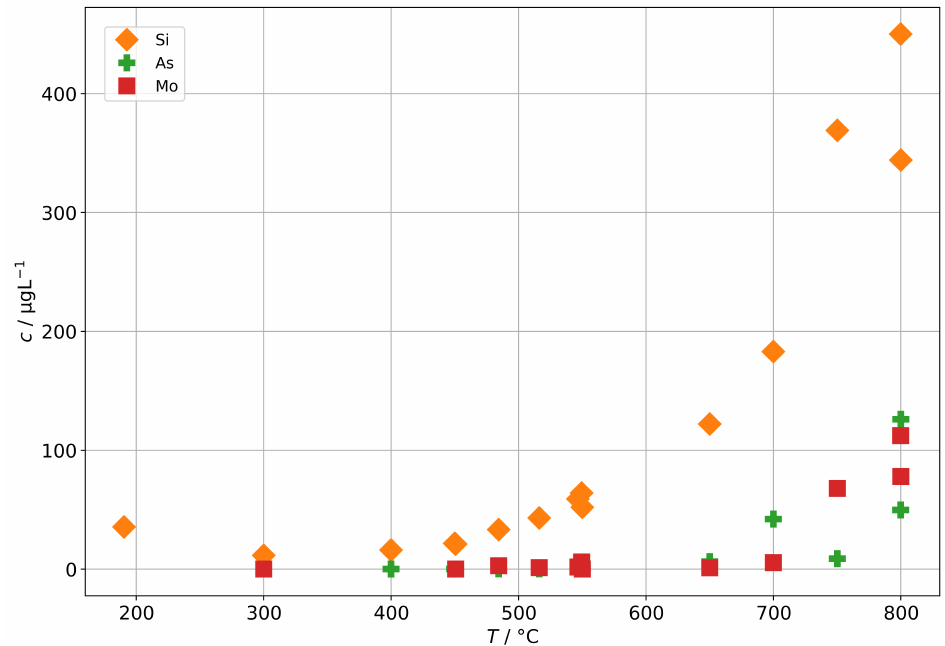
Figure 12. Concentrations of silicon, arsenic, and molybdenum in steam condensates obtained after the fuel gas preheater in dependence of the preheater operation